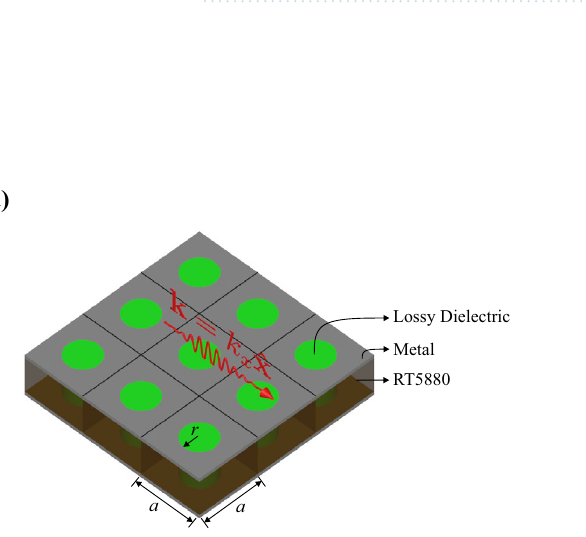
Figure 2. ( a ) Schematic of the proposed power splitter, not including any vias, for which the geometry parameters are L tap the unit of mm. ( b ) Transmission coefficients from the input port (No. 0) to the output ports (Nos. 1, 2, 3, 4), as well as input reflection coefficient, as functions of frequency.